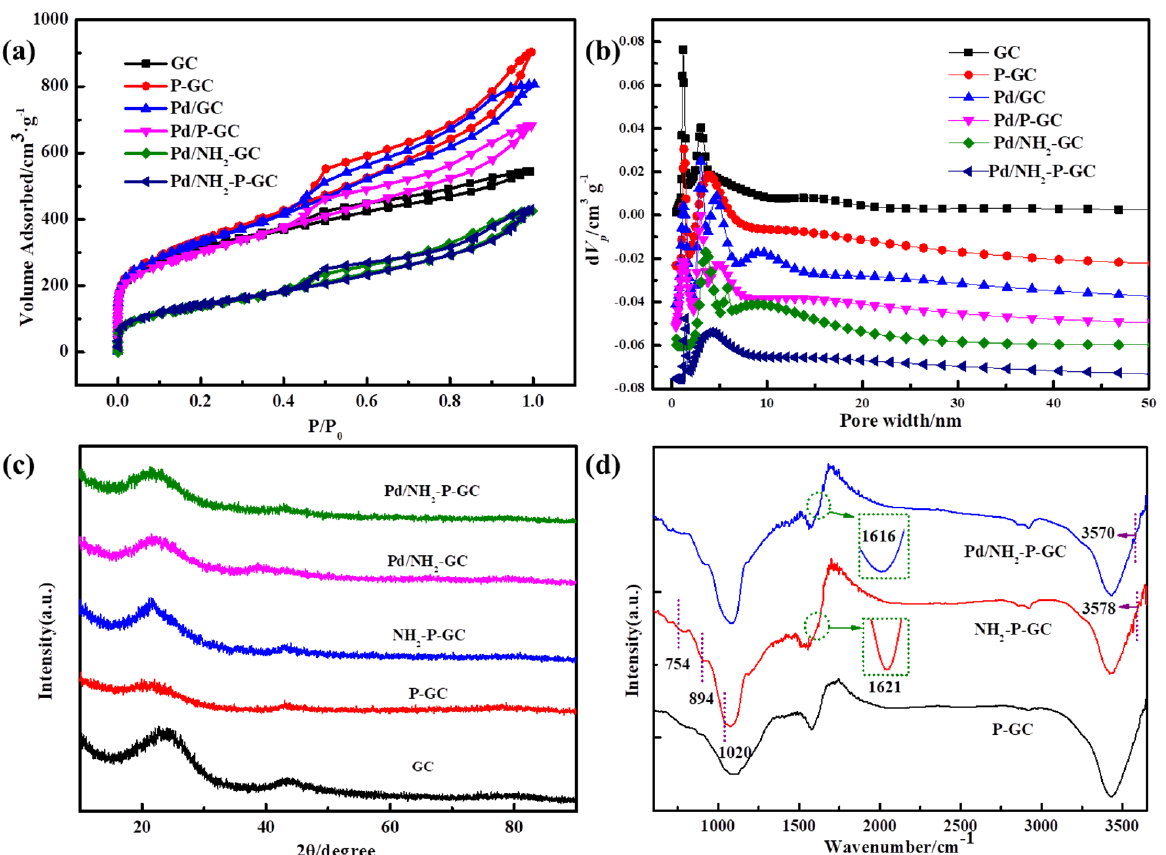
Figure 2. ( a ) Nitrogen adsorption–desorption isotherms and ( b ) corresponding pore size distribution curves of GC, P-GC, Pd/GC, Pd/P-GC, Pd/NH 2 -GC and Pd/NH 2 -P-GC. ( c ) XRD patterns of GC, P-GC, NH 2 -P-GC, Pd/NH 2 -GC and Pd/NH 2 -P-GC. ( d ) FT-IR spectra of P-GC, NH 2 -P-GC and Pd/NH 2 -P-GC. Table 1. Textural characteristics of various samples. Sample